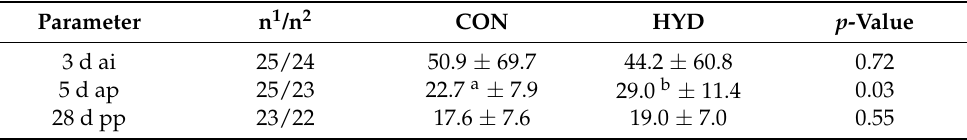
Table 6. Effect of dietary vitamin D source on standing time after feeding (mean ± SD, min).